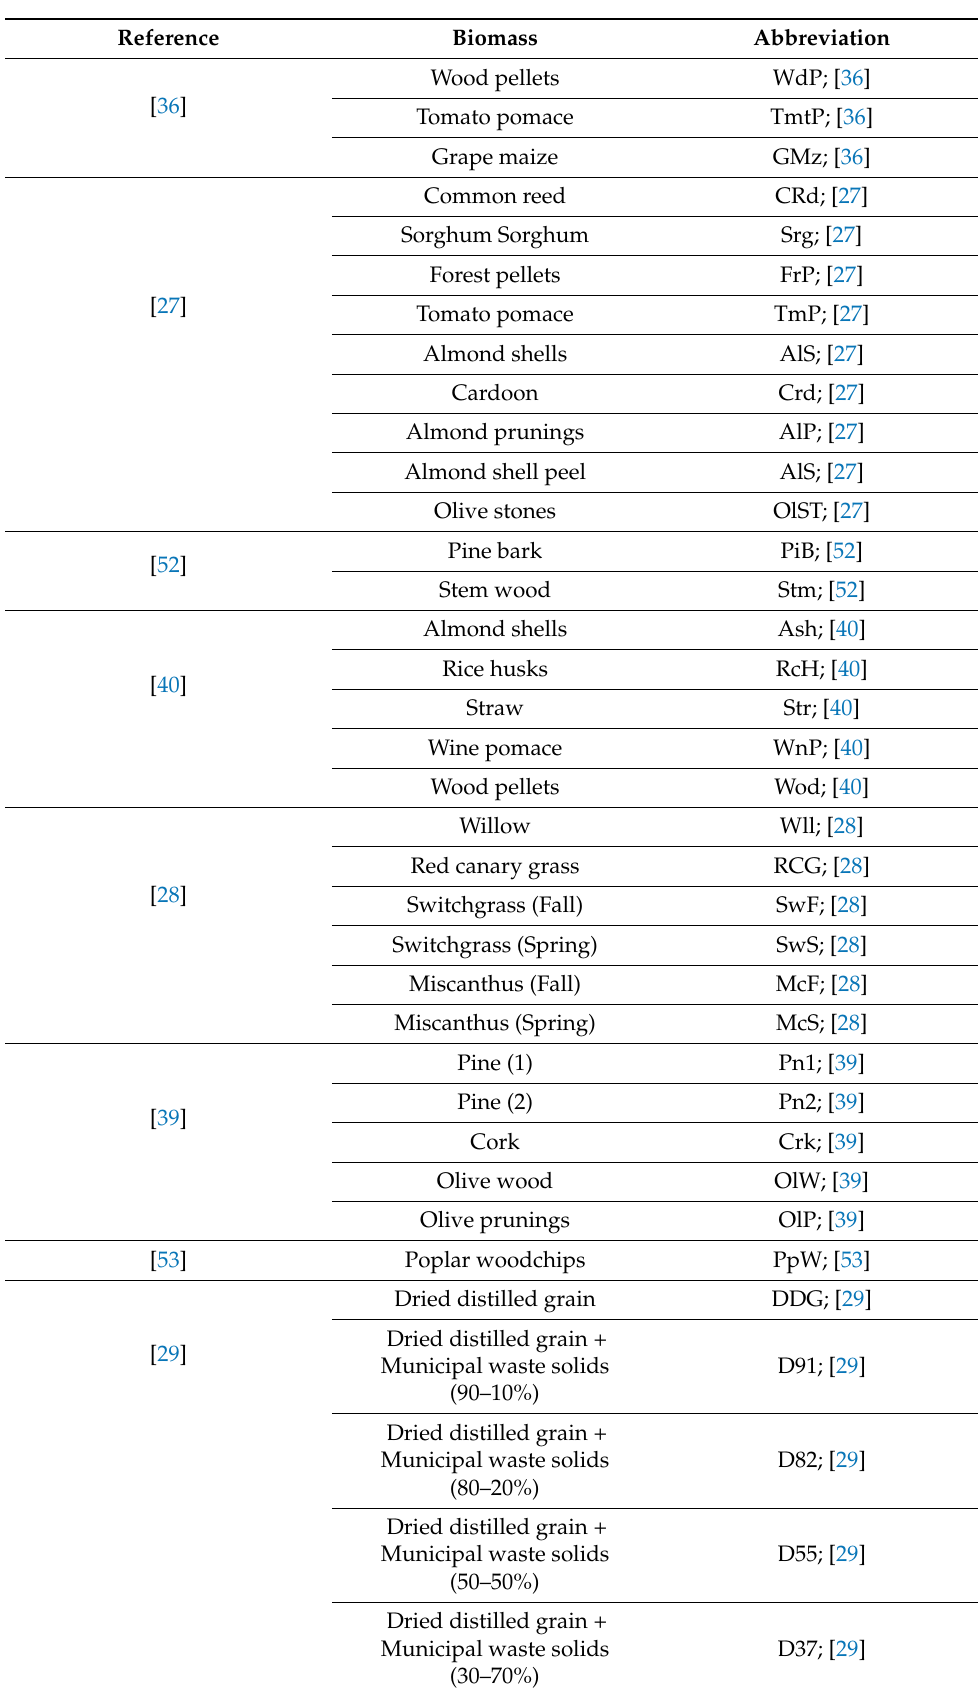
Table A2. Abbreviations used on the Y -axis of Figure A12 and the biomass type studied in the various works